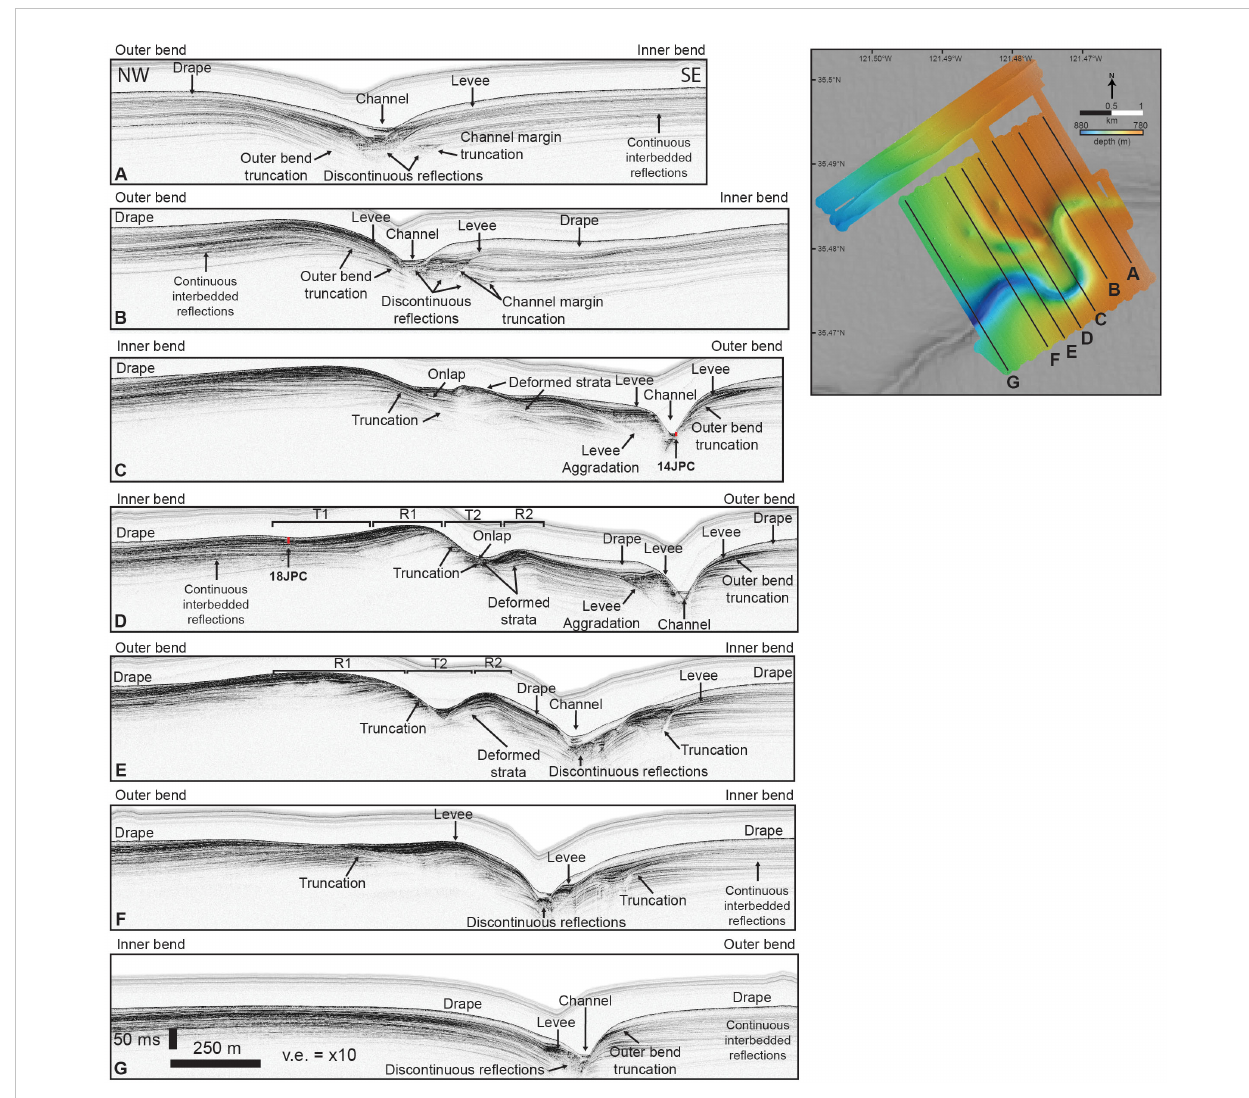
FIGURE 3 Annotated chirp pro fi les and map view locations from the AUV bathymetric survey. Locations of 14JPC and 18JPC (Figure 5) and approximate penetration depths are noted by the red rectangles. All pro fi les from left to right trend from northwest to southeast. (A – G) refer to the location of the cross sections relative to the plan view survey image